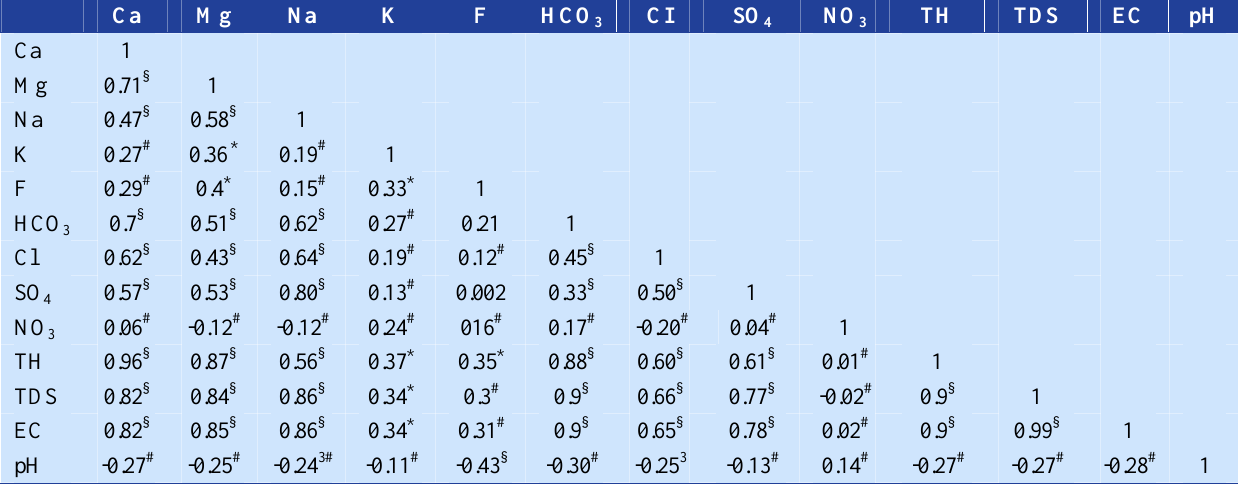
Figure 1. Fluoride concentration of different sampling sites in wet and dry seasons Table 1. Correlation matrix of studied water quality parameters